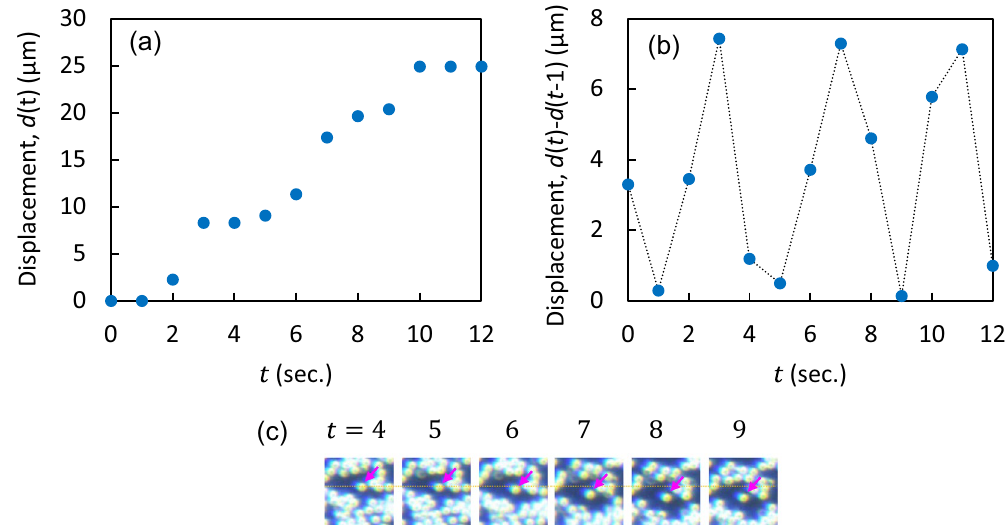
Figure 5. Possible range of the weights w 1 and w 2 at N = 4 with the constraint as value of w 3 : ( a ) w 3 = 0.1 and ( b ) 0.45. This region is filled with bright red. The blue hatched region is the possible range without the constraint on w 4 .